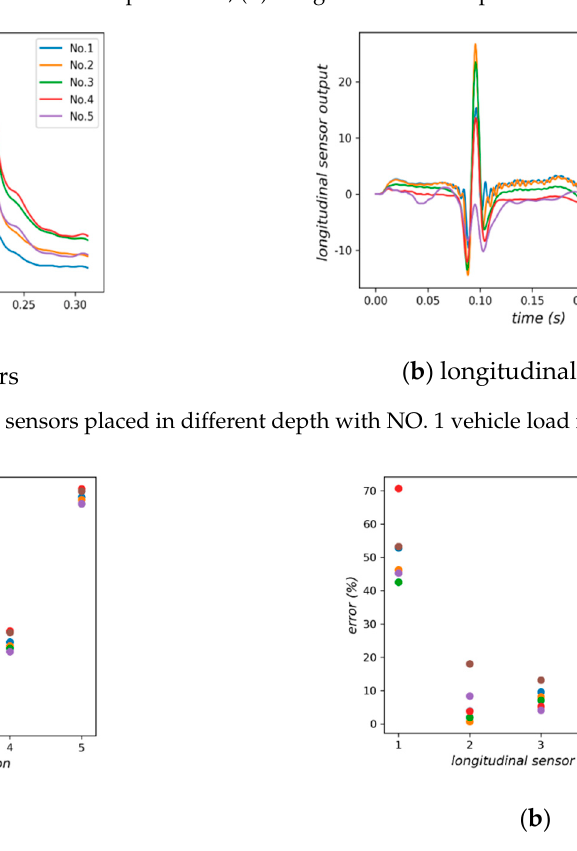
Figure 12. ( a ) Lateral sensor placement; ( b ) Longitudinal sensor placement.